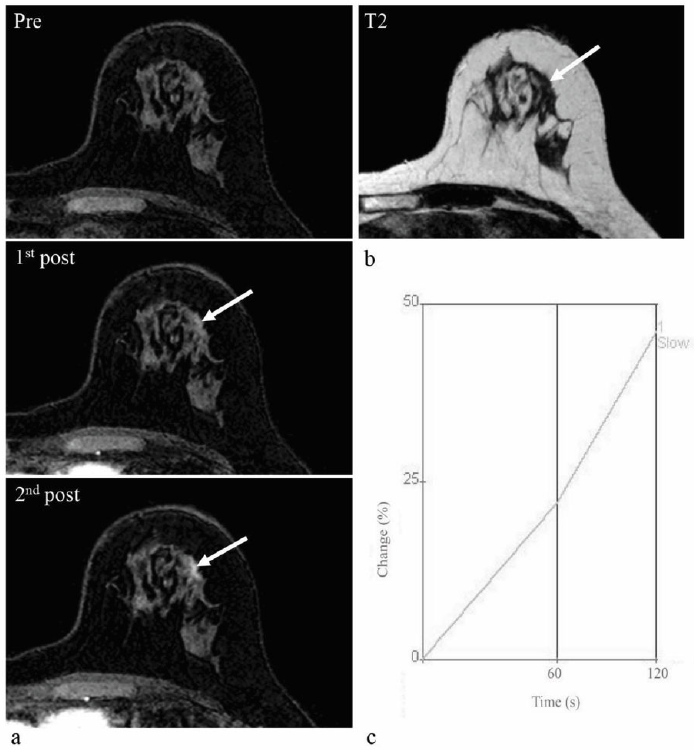
Figure 4. Screening abbreviated breast MRI (AB-MRI) images of a 48-year-old woman with a history of right total mastectomy and left breast-conserving surgery due to bilateral breast cancer. Two years after surgery, pre-contrast and two post-contrast-enhanced axial images ( a ) show a 0.9 cm irregular enhancing mass (arrows) in the left breast at the 1 o’clock direction. The T2 signal intensity is not high ( b ). This lesion was assessed as BI-RADS 4B category in the original report. According to the interpretation guideline, it is classified as a suspicious lesion for which biopsy is